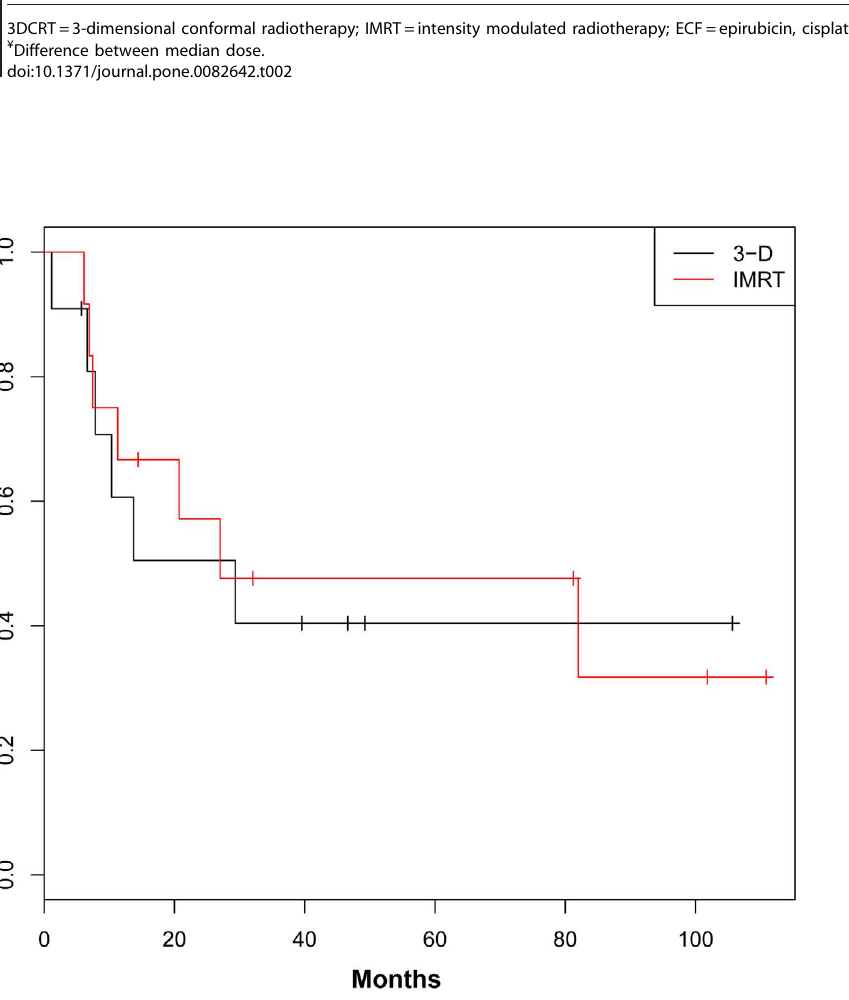
Figure 1. Disease-Free Survival. doi:10.1371/journal.pone.0082642.g001 PLOS ONE |